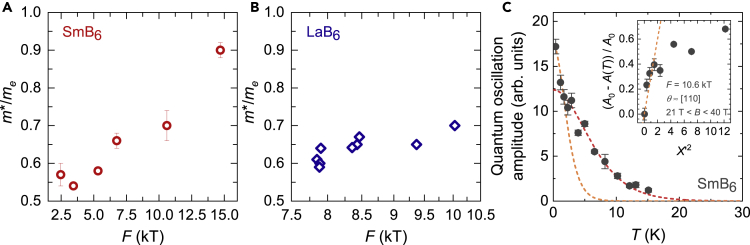
Effective Mass and Quantum Oscillation Temperature Dependence(A and B) Comparison of the quasiparticle effective masses as a function of oscillation frequency (A) for floating zone-grown SmB6 measured along [110] (for temperatures down to 1 K) from Hartstein et al. (2018), and (B) for LaB6 measured along different field directions based on Ōnuki et al. (1989); Ishizawa et al. (1977); Onuki et al. (1989); Ishizawa et al. (1980); Arko et al. (1976); Suzuki et al. (1987). Error bars in (A) reflect the error from fitting the temperature dependence of quantum oscillation amplitude to the Lifshitz-Kosevich formula. The effective mass of frequencies corresponding to the large α ellipsoids in both materials scale roughly linearly with the oscillation frequency, as expected for Fermi surface sections that originate from the same band.(C) The temperature dependence of quantum oscillation amplitude of the 10.6 kT frequency observed in floating zone-grown SmB6 in a magnetic field window of 21–40 T and a temperature range 30 K–550 mK, showing a prominent low-temperature increase. Error bars reflect the FFT noise floor. The inset shows the growth of the 10.6 kT frequency amplitude A(T) with respect to A0, the amplitude at the lowest measured temperature, as a function of X′2, where X′=2π2kBTme/eℏB, the temperature damping coefficient in the Lifshitz–Kosevich formula, as expected for the Fermi Dirac statistical distribution (Shoenberg, 1984). The low temperature growth in amplitude is linear in X′2 (shown by orange dashed line), in contrast to the predicted suppression of temperature-dependent amplitude growth at low temperatures for gapped models. As reported previously in Tan et al. (2015); Hartstein et al. (2018), a deviation from the Lifshitz–Kosevich temperature dependence is seen at the lowest temperatures for the dominant low frequency oscillation, reminiscent of the low temperature upturn of the linear term of specific heat capacity. A similar deviation from the Lifshitz–Kosevich form can also potentially be seen in the high oscillation frequencies; an example using the 10.6 kT frequency is shown here. The red dashed line shows a Lifshitz–Kosevich simulation with effective mass m∗/me = 0.7 that fits the amplitude as a function of temperature for T>≈1 K, while the orange dashed line shows a Lifshitz–Kosevich simulation with effective mass m∗/me = 1.8 that fits the amplitude as a function of temperature for T<≈1 K.